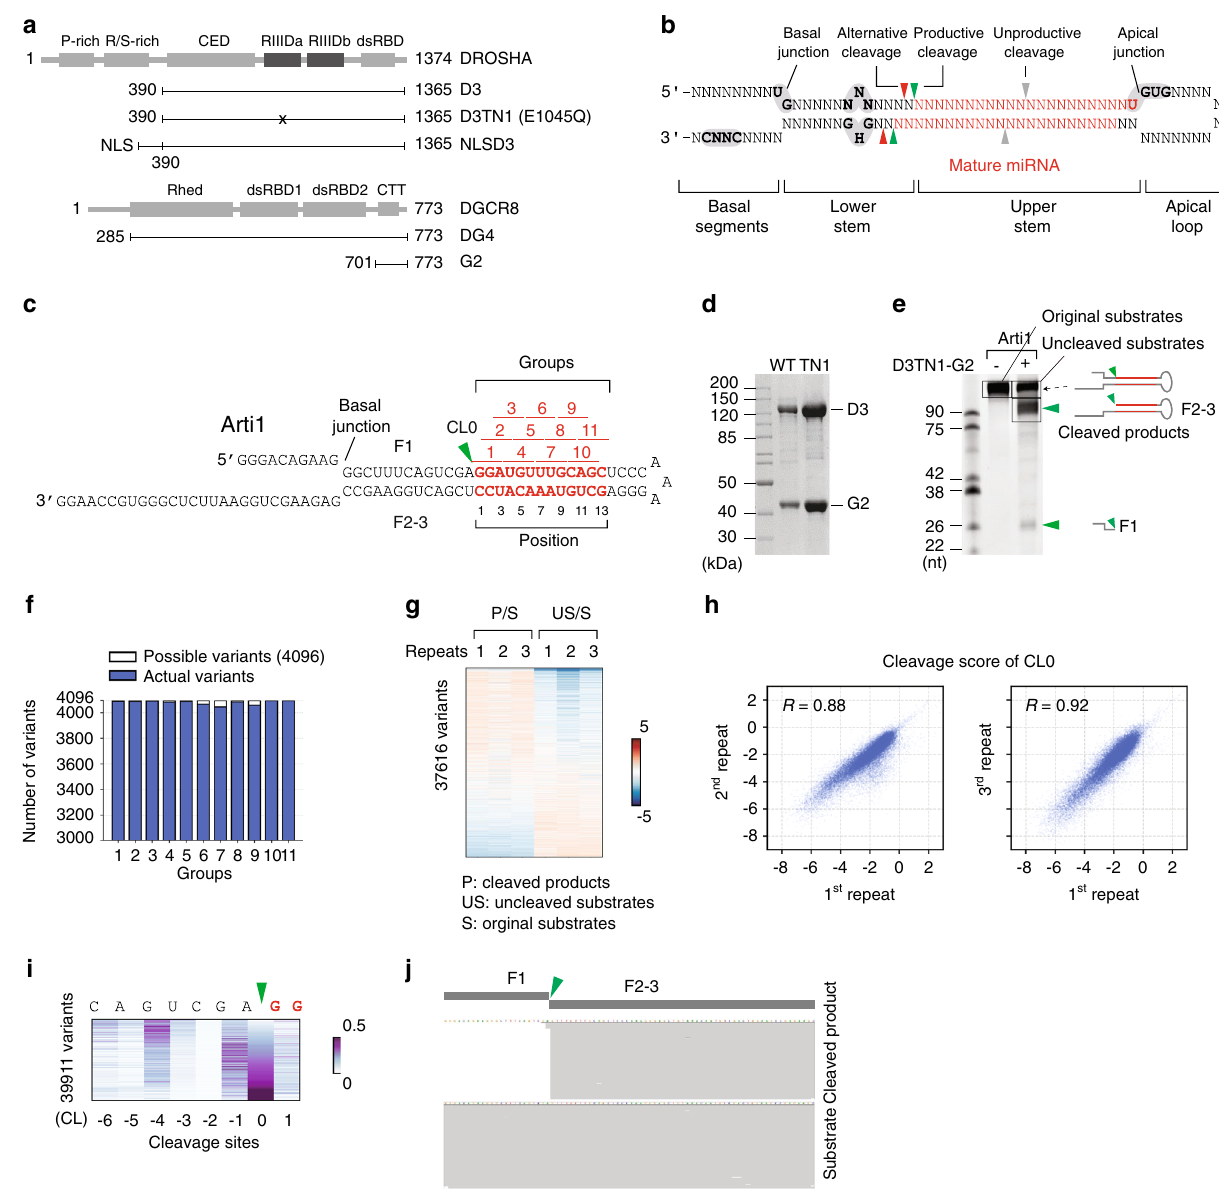
Fig. 1 High-throughput pri-miRNA processing assays. a The protein constructs used in this study. The fi rst and last residue numbers for each construct are shown. The mutation site is marked with an ‘ x ’ . P-rich: Proline-rich domain; R/S-rich: Arginine/serine-rich domain; CED: Central domain; RIIIDa and RIIIDb: RNase III domains; dsRBD: double-stranded RNA-binding domain; Rhed: RNA-binding heme domain; and CTT: C-terminal tail region. b The structure of a typical pri-miRNA, which is the substrate for Microprocessor, has a stem-loop con fi guration. The green, red, and gray arrowheads indicate the productive, alternative, and unproductive cleavage sites of DROSHA. The red letters indicate the miRNA sequence. The letters highlighted in gray show the identi fi ed RNA motifs. c Structure of the arti1 substrate. The green arrowhead indicates the DROSHA cleavage site on the 5p-strand, and the red letters represent the randomized region, which is divided into 11 groups. Each group contains 3 pairs of randomized nucleotides. d SDS-PAGE to show the purity of the D3-G2 and D3TN1-G2 complexes. e Processing of arti1 by D3TN1-G2. Arti1 (12 pmol) was incubated with D3TN1-G2 (20 pmol) for 120 min at 37 °C in 10 μ l standard reaction buffer, as described in the Methods section. f Stacked bar graph to show the total number of arti1 variants in each group. The total numbers of actual variants from 3 repeats are shown in blue, whereas the theoretical numbers of the possible variants are shown in white. The theoretical variant number of each group is 4 6 (4096). g The cleavage score of D3TN1-G2 estimated from 3 repeats, colored according to the color bar (right). P: cleaved products; S: original substrates; and US: uncleaved substrates. h The reproducibility of the 3 repeats. The CL0 cleavage score of one repeat was plotted against that of another. The CL0 is the canonical cleavage site. i The relative positional cleavage frequency of DROSHA at different positions ranging from 7 to 14 nt from the basal junction of each variant, colored according to the color bar (right). Number “ 0 ” indicates the cleavage site 13 nt from the basal junction. The cleaved products that resulted from each variant substrate were collected, and their relative percentage was estimated between 0 and 1. j The representative substrate and product sequence of a variant visualized by IGV 47 . The reads resulting from the NGS were aligned to the referenced sequence of arti1. The source data are provided in the Source Data fi